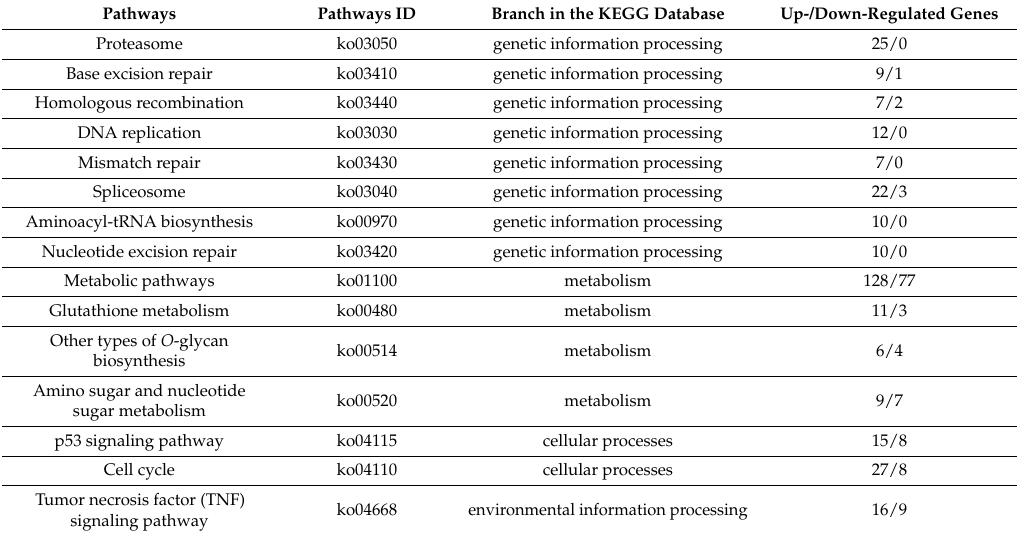
Table 4. The 15 significant enrichment of pathways for differentially expressed genes (DEGs). The pathway ID was obtained from the KEGG database. Pathways with a corrected p value < 0.05 were significantly